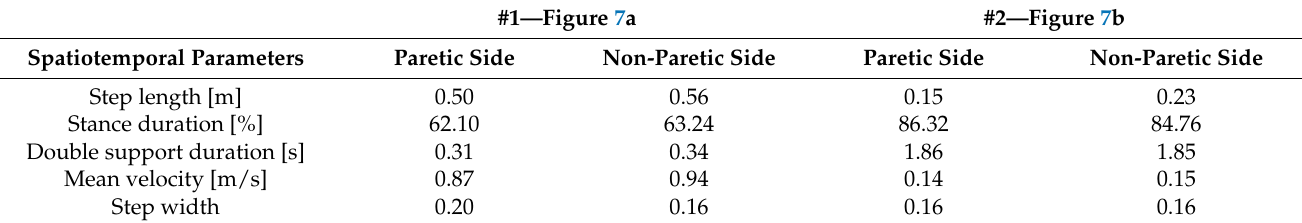
Table 4. Spatiotemporal parameters for the paretic and non-paretic sides of gait patterns shown in Figure 7.